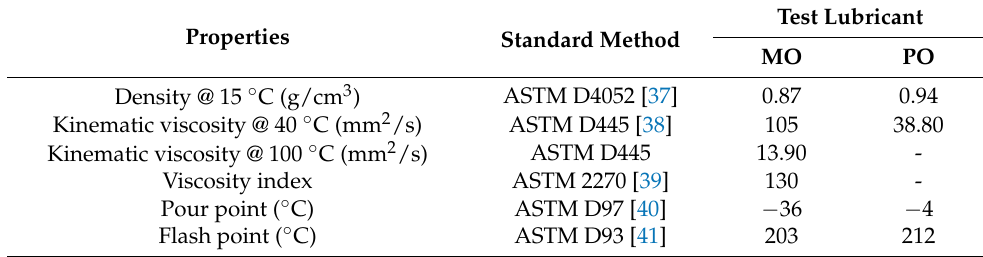
Table 2. Physicochemical properties of base oils.